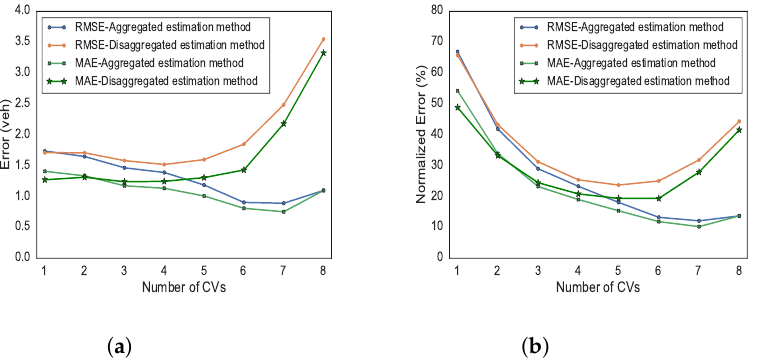
Figure 11. Accuracy measure of estimated total vehicle counts based on the number of CVs ( a ) RMSE and MAE ( b ) NRMSE and NMAE.